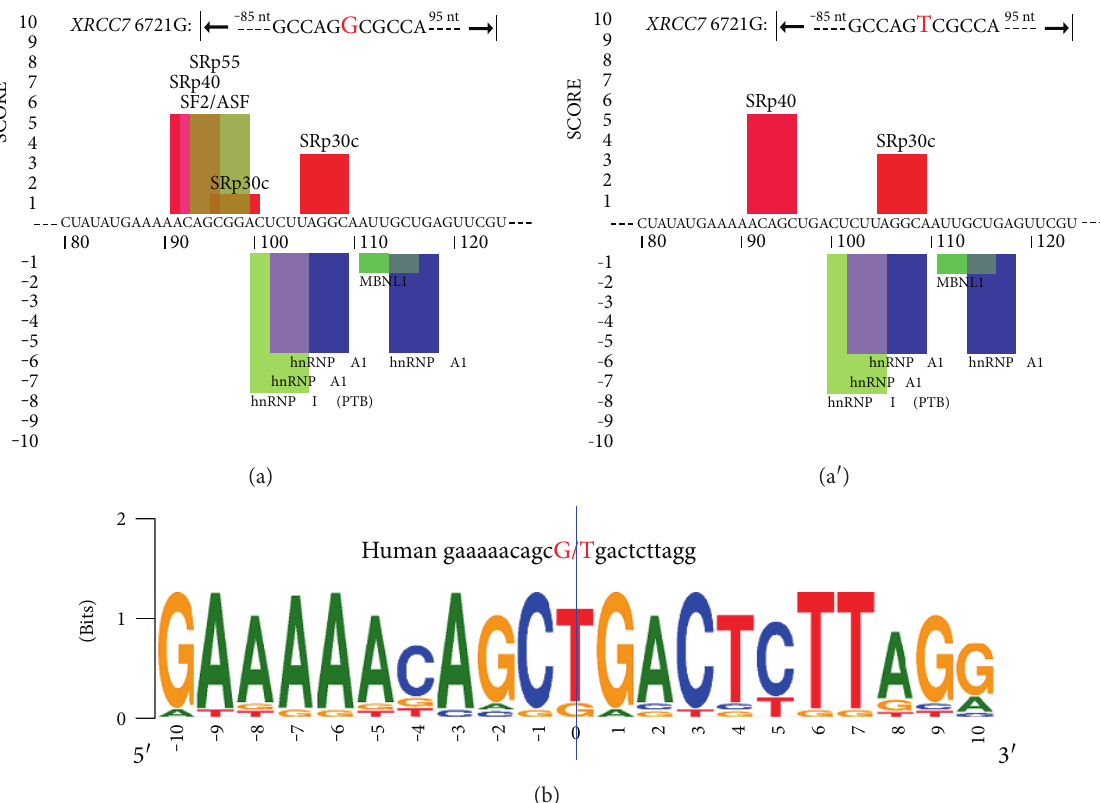
Figure 6: Enhancers and silencers of the XRCC7 6721G > T DNA sequence fl anking motif and its sequence conservation: screening of the DNA sequence fl ankings of XRCC7 6721G > T for enhancer and silencer motif via SpliceAid 2 tool (a and a ′ ); illustration of sequence conservation of the XRCC7 6721 across multiple mammalian species